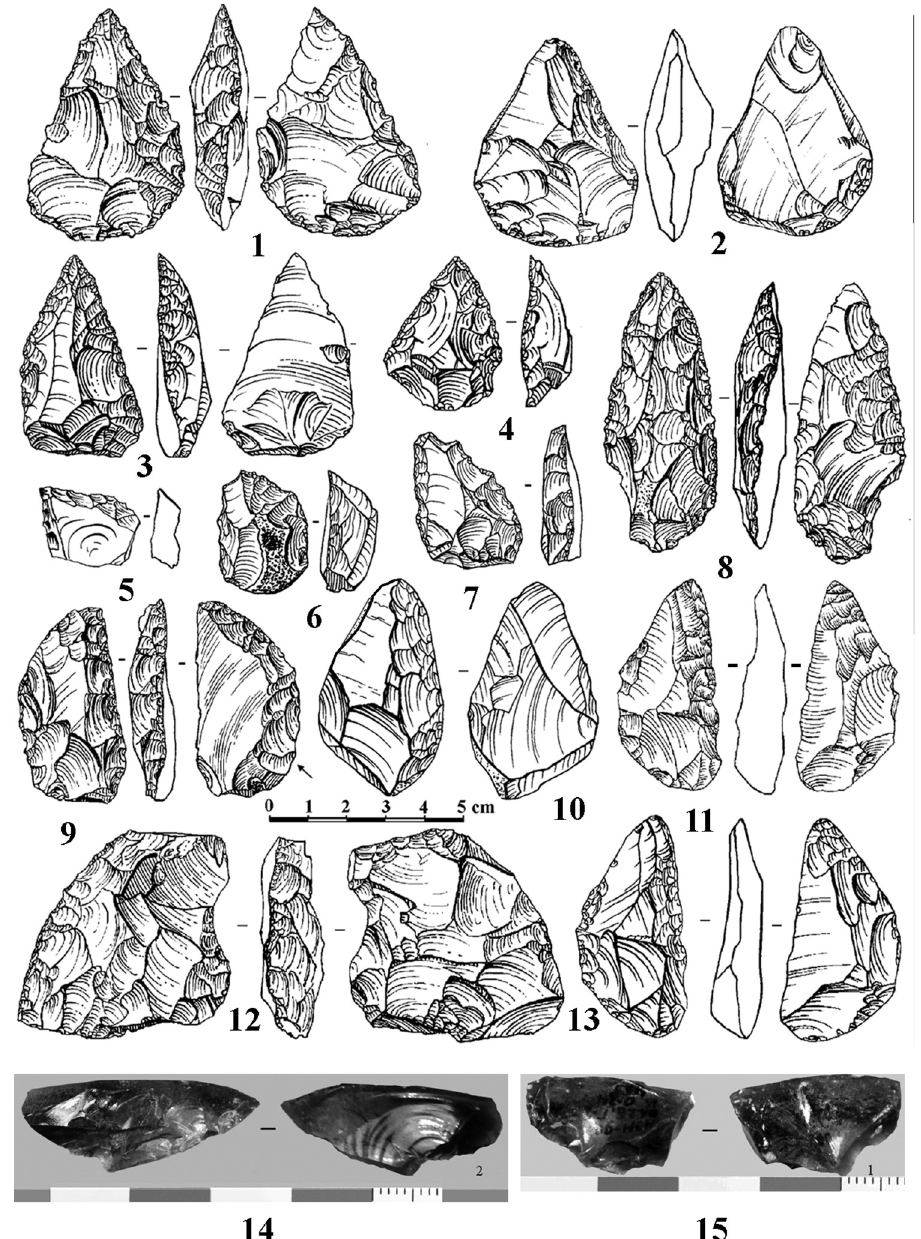
Fig 2. Mezmaiskaya cave. The retouched tools typical for the Eastern Micoquian (1–13) and small obsidian flakes found in layers 3 and 2B4 (14–15). 1, 2 –bifacial small handaxes; 3, 4 –Mousterian points; 5–7 – déjeté scrapers; 8 – bifacial leaf point; 9–13 –bifacial